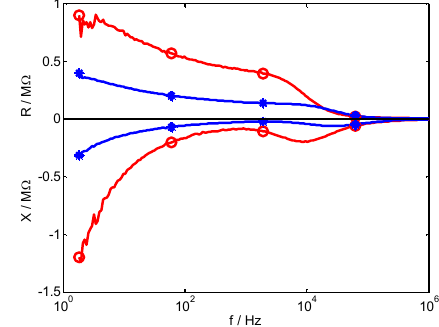
Fig.13: Impedance spectrum (real and imaginary part) of a 0.125 mm 2 – gold electrode made from a CD-R. (o - 0.055 mM PBS, * - 2.18 mM